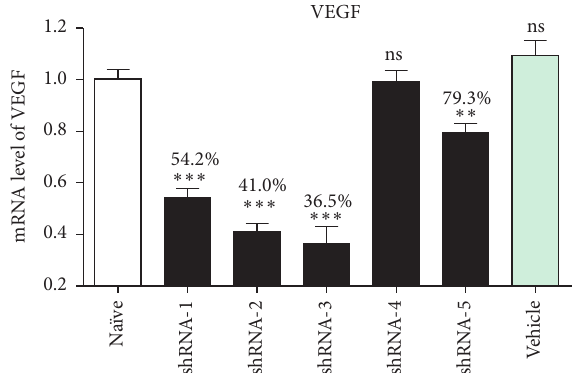
Figure 1: RNA interference after transfection with VEGF-shRNA. ∗∗ 𝑝 < 0.1 ; ∗∗∗ 𝑝 < 0.01